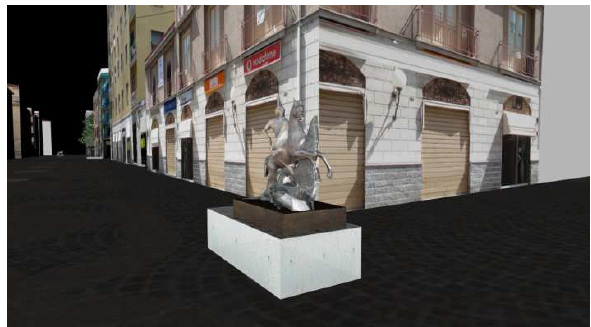
Figure 6. The model of St. George and the Drake obtained with C10 scans in the city model